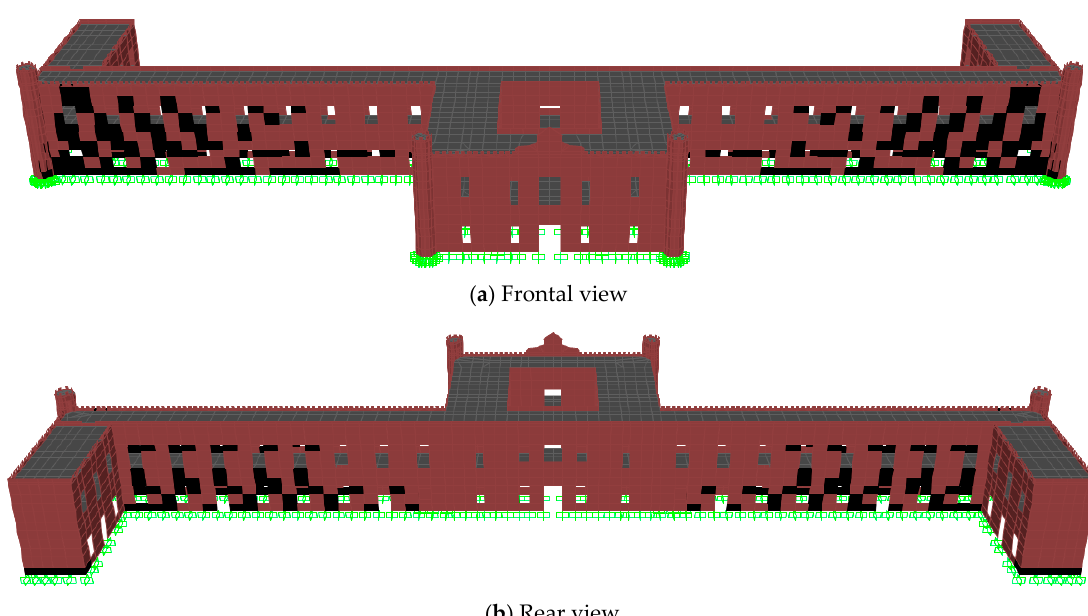
Figure 17. Elements with reduced elastic modulus.